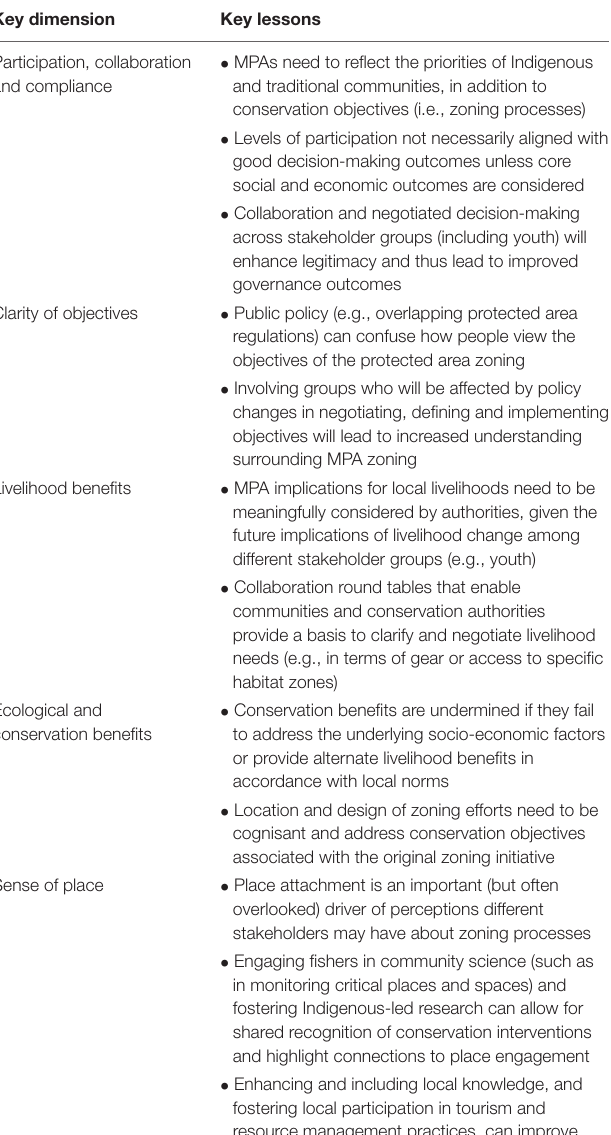
TABLE 3 | Summary of key lessons